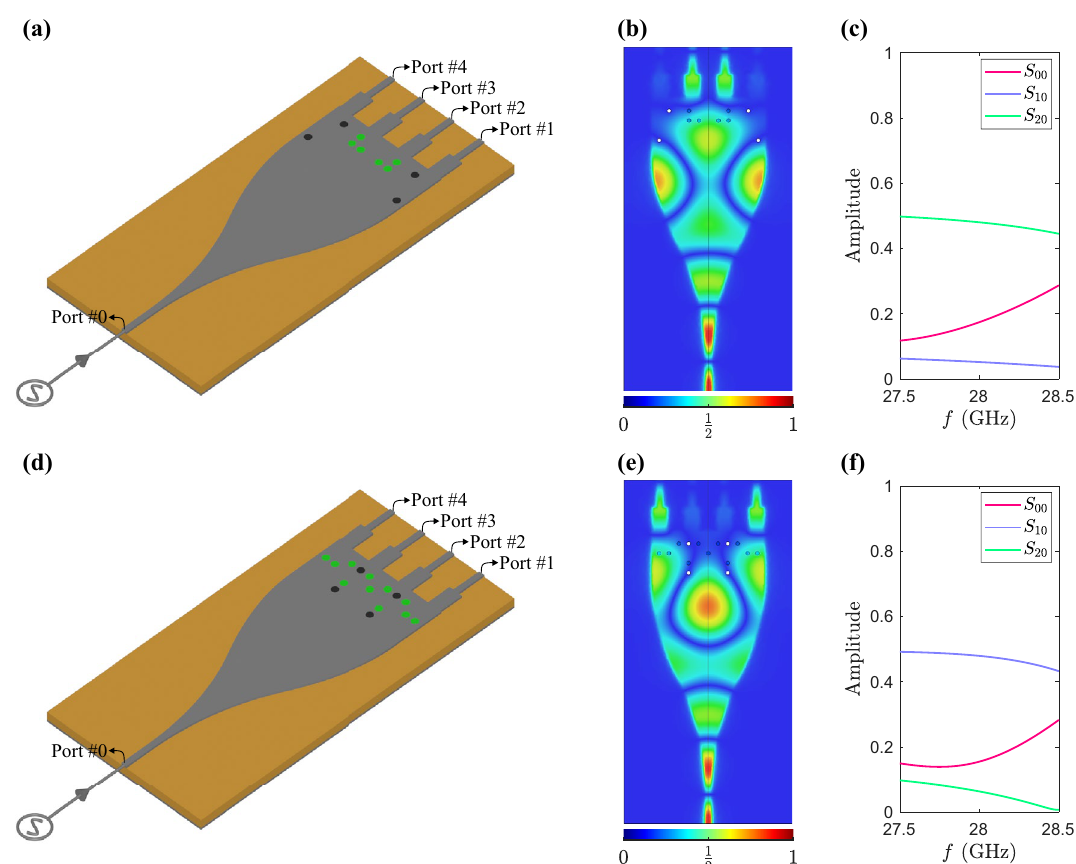
Figure 5. ( a ) and ( d ) Two different distributions for dielectric and PEC vias leading to transmittances which are totally dissimilar. ( b ) and ( e ) Normalized electric field profiles, which are full-wave simulation results. ( c ) and ( f ) Amplitude of scattering parameters for each via